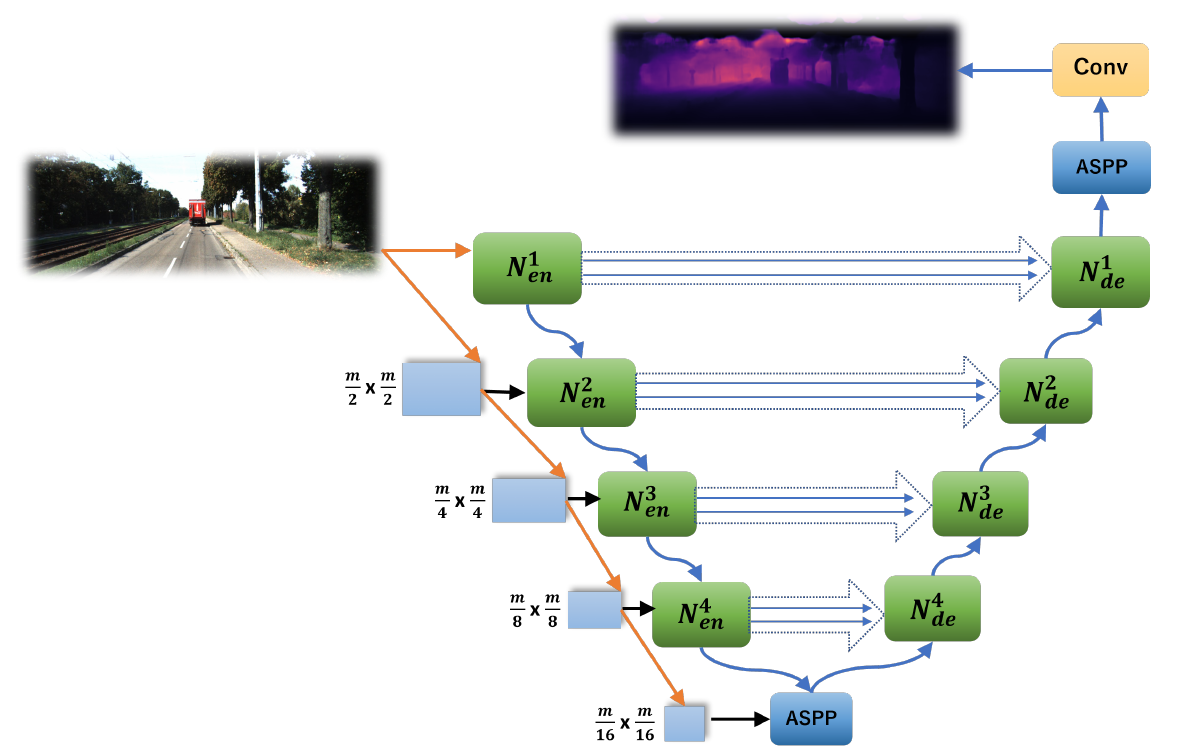
Figure 1. The overall design of our network architecture.